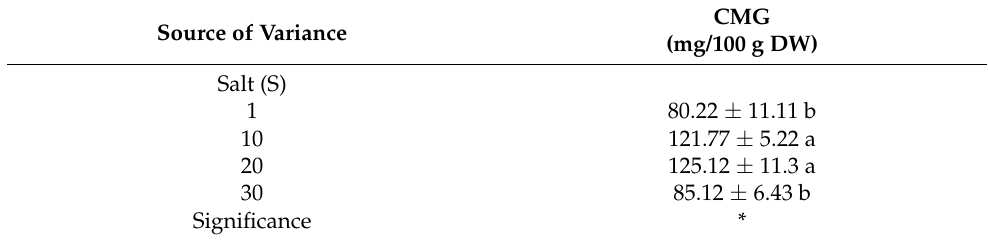
Table 5. Main effect of the salt concentration on cyanidin-malonyl glucoside (CMG) content of the ‘Red Salad Bowl’ cultivar. The significance was evaluated with a one-way ANOVA (*: p < 0.05). Different letters indicate different homogenous groups according to Duncan’s multiple range